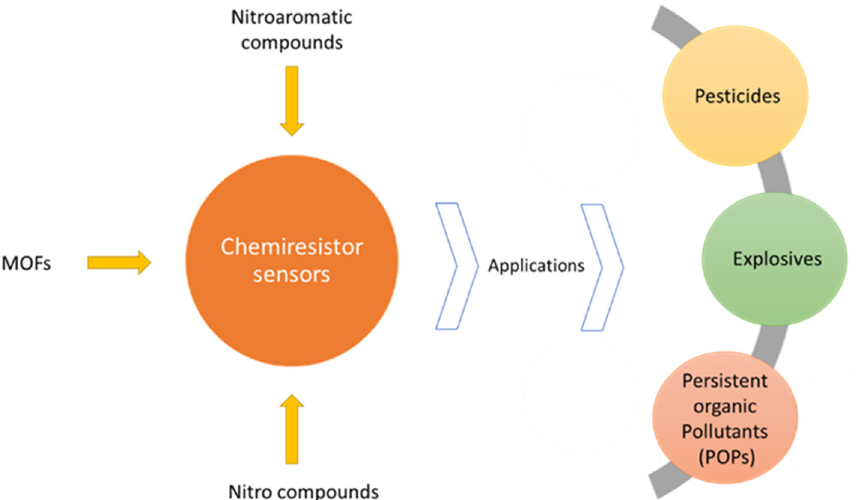
Figure 6. Chemiresistor sensor and its